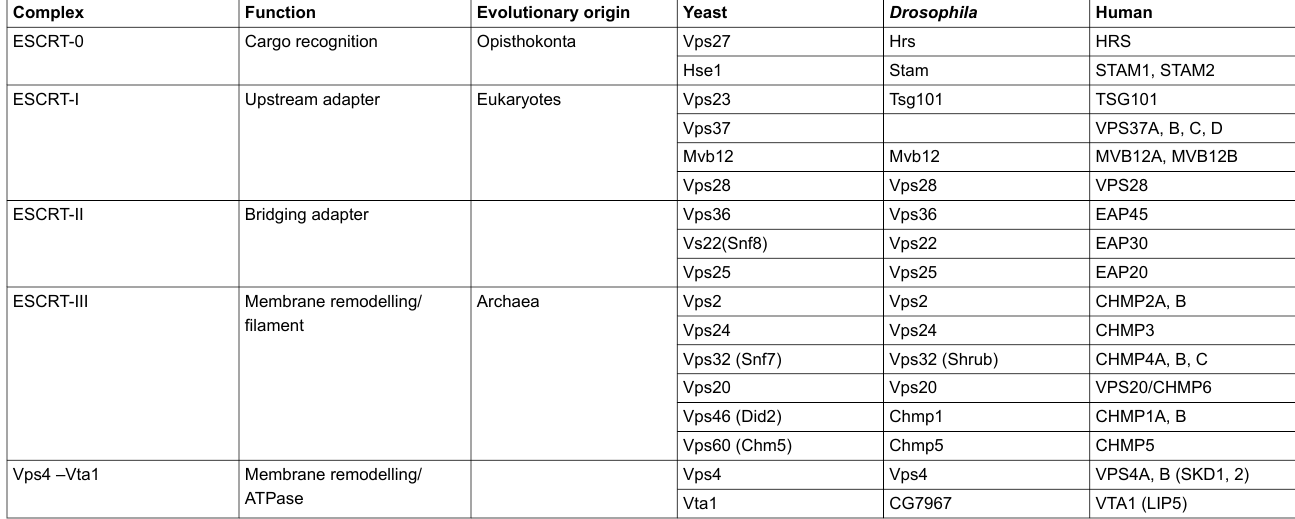
Table 1: Composition of the ESCRT (endosomal sorting complexes required for transport) complexes in endosomal sorting. Complex